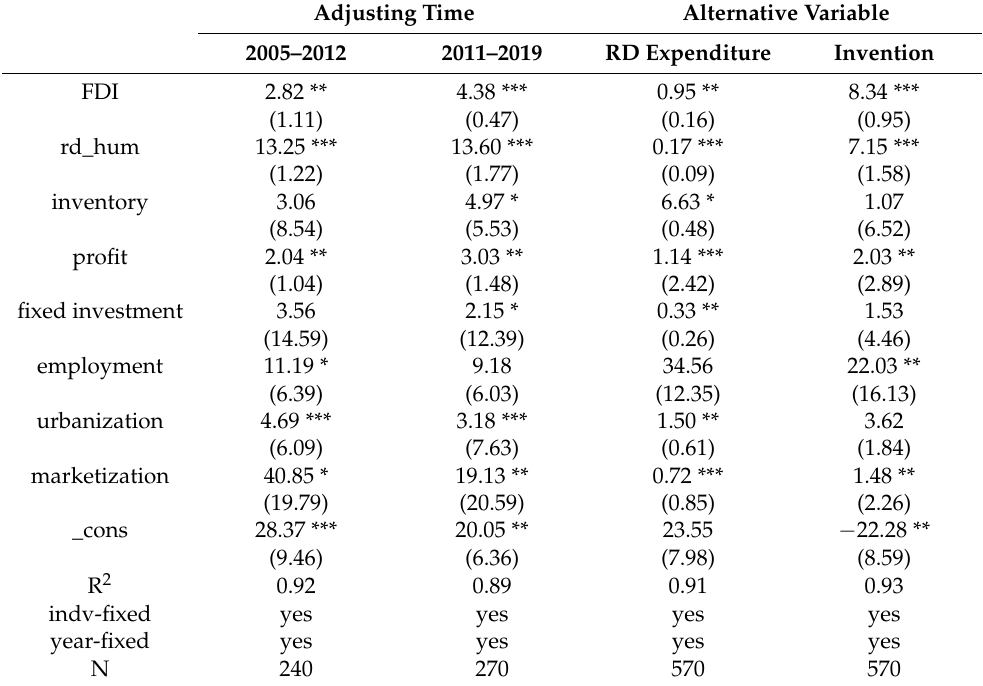
Table 4. Robustness